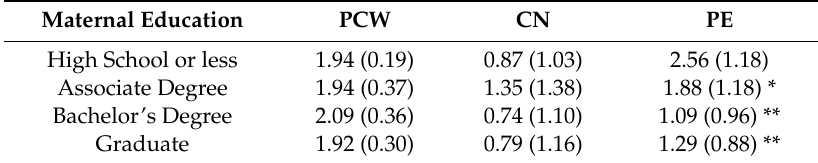
Table 5. One-way ANOVA of CFQ factors score with respect to the maternal education and weight categories.